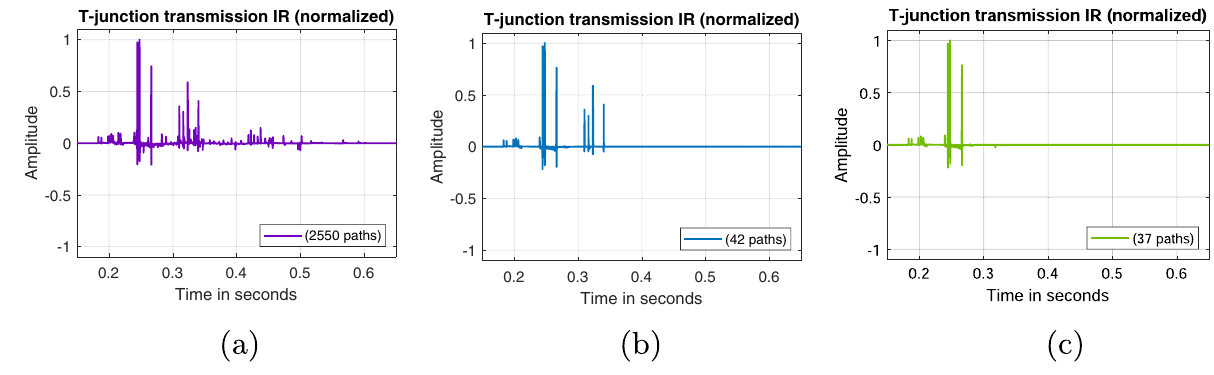
Figure 11. Normalized impulse series of T-junction propagation paths under different reduction approaches. (a) No path reduction, (b) dynamic range culling, (c) perceptual culling.